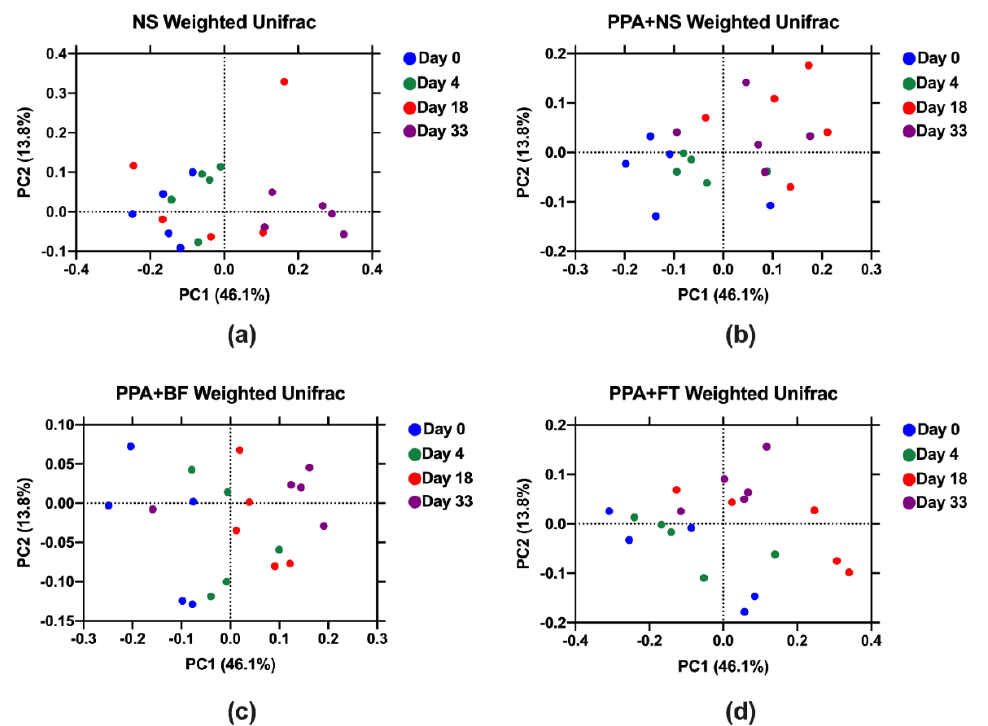
Figure 3. Principal coordinate analysis of weighted UniFrac distances in each group. Total number of reads per samples was equalized to 24,000. Normal saline (NS) control group ( a ), propionic acid (PPA + NS) control group ( b ), Bifidobacterium (PPA + BF) treated group ( c ), and fecal microbiota transplantation treated (PPA + FT) group ( d ). Each circle represents one sample, and percentage of variance explained by each component is presented for each